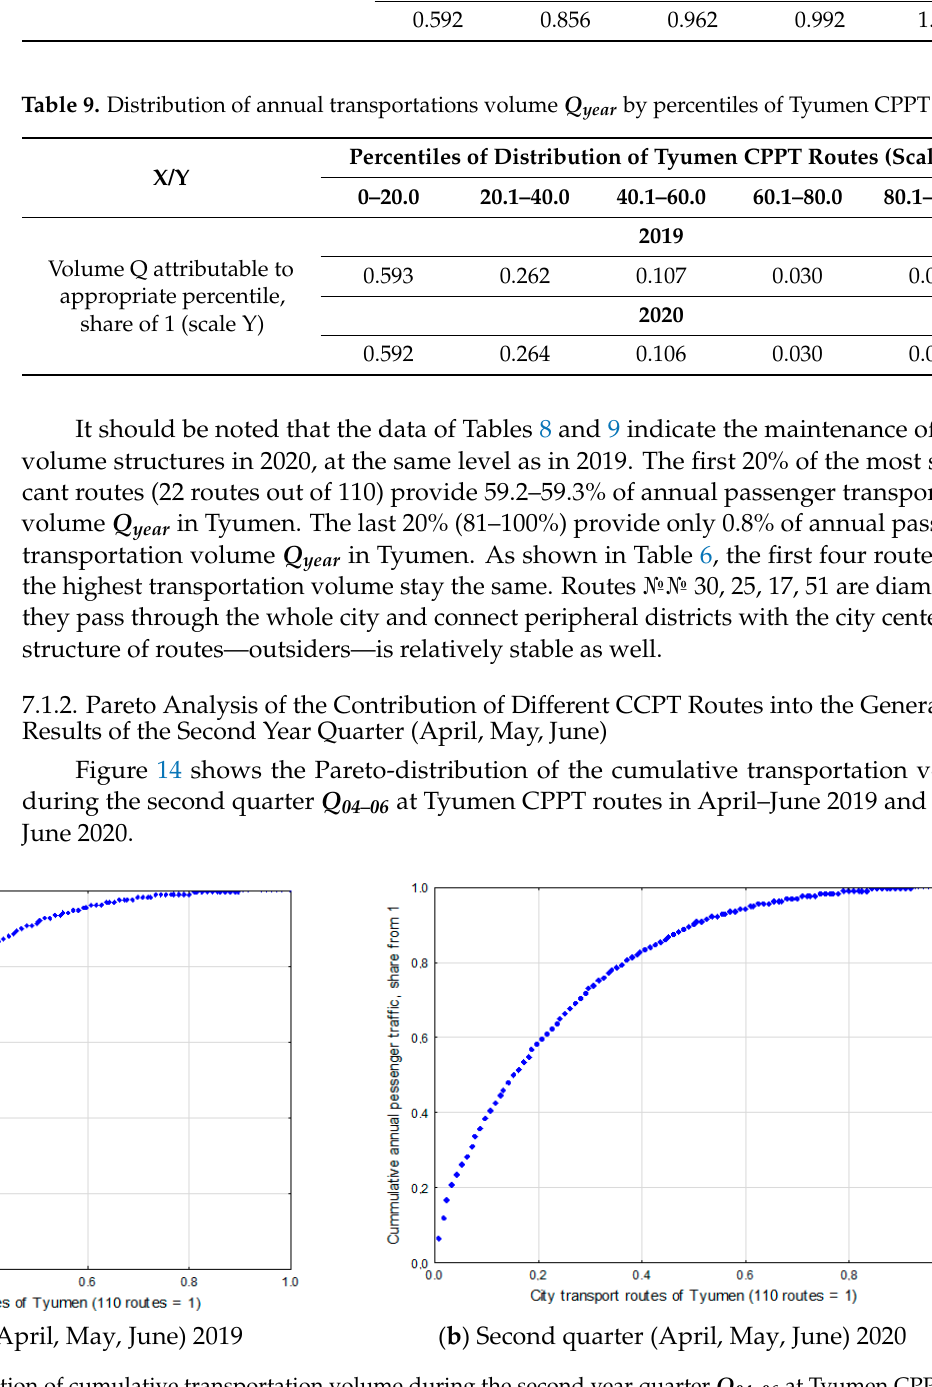
Table 10. Characteristics of the cumulative curve (Lorenz curve) of distribution of the transportation volume Q 04–06 at Tyumen CPPT routes. X/Y Percentiles of Distribution of Tyumen CPPT Routes (Scale X) 20